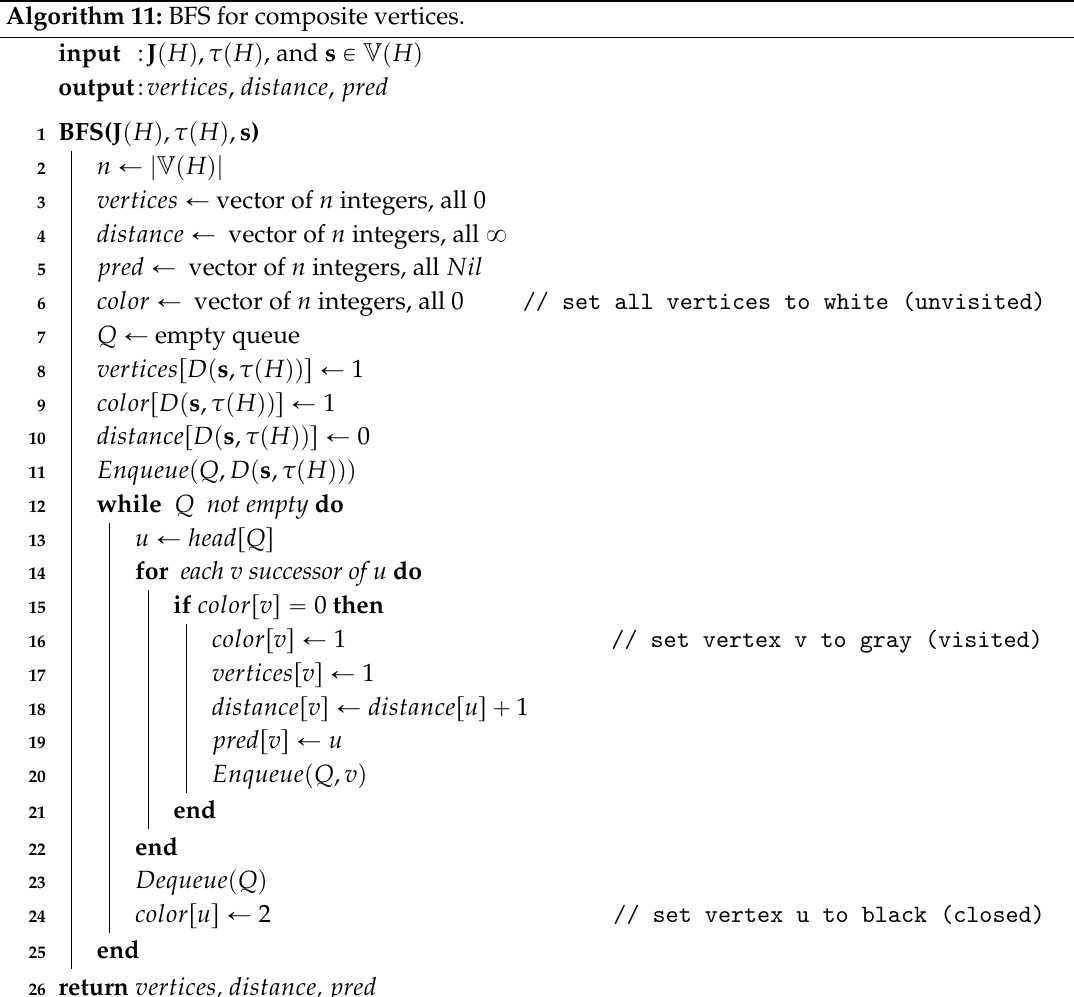
Algorithm 11: BFS for composite